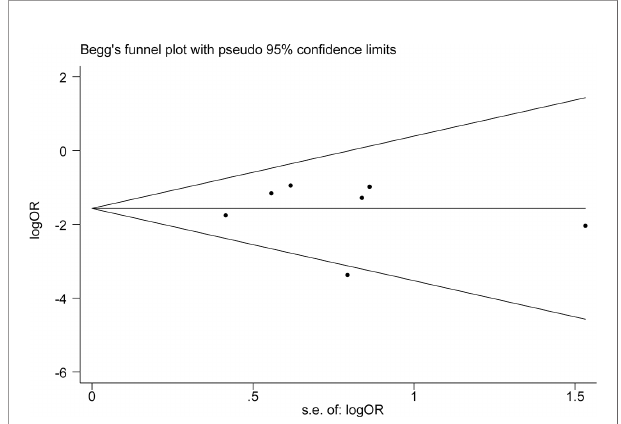
FIGURE 4 | Evaluation of publication bias. Begg ’ s funnel plot was used to detect publication bias in 6-month OS rate. Each dot in the funnel plot represents a study. Those points are symmetrical on both sides of the reference line, indicating no publishing bias. OS, overall survival; OR, odds